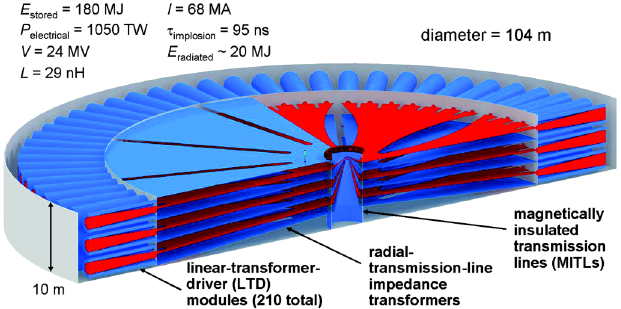
FIG. 1. (Color) Proposed architecture of a petawatt-class pulsed- power accelerator for z -pinch experiments in Ref. [1]. The LTD modules drive the radial-transmission-line impedance transform- ers, which in turn drive the MITLs, and ultimately, the z -pinch load in the center of the